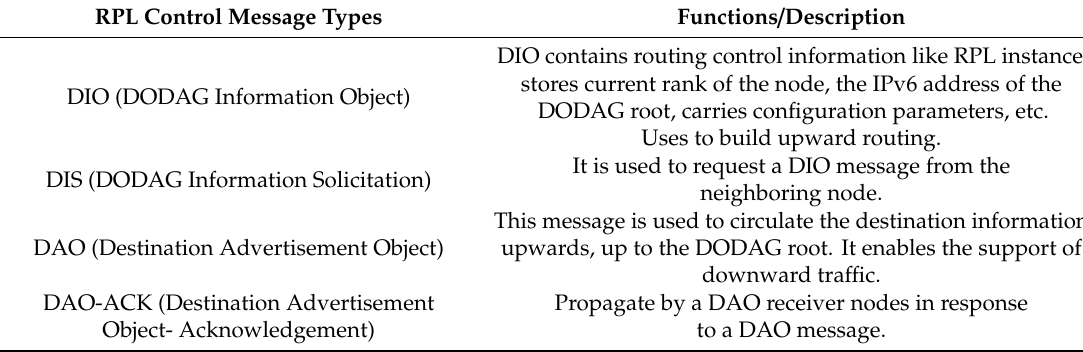
Table 1. Type 155 ICMPv6 RPL control